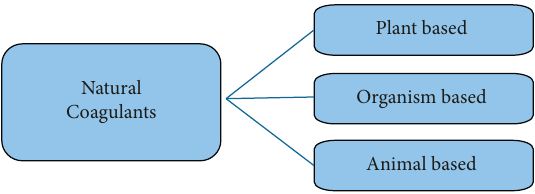
Figure 1: Classification of natural